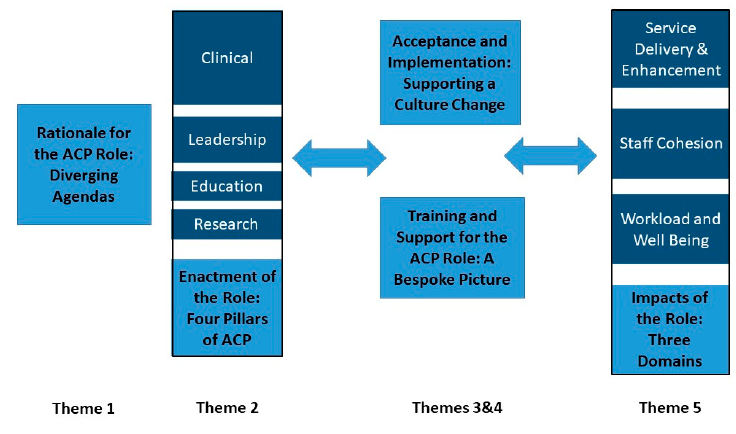
Figure 1. Figure 1. Themes.